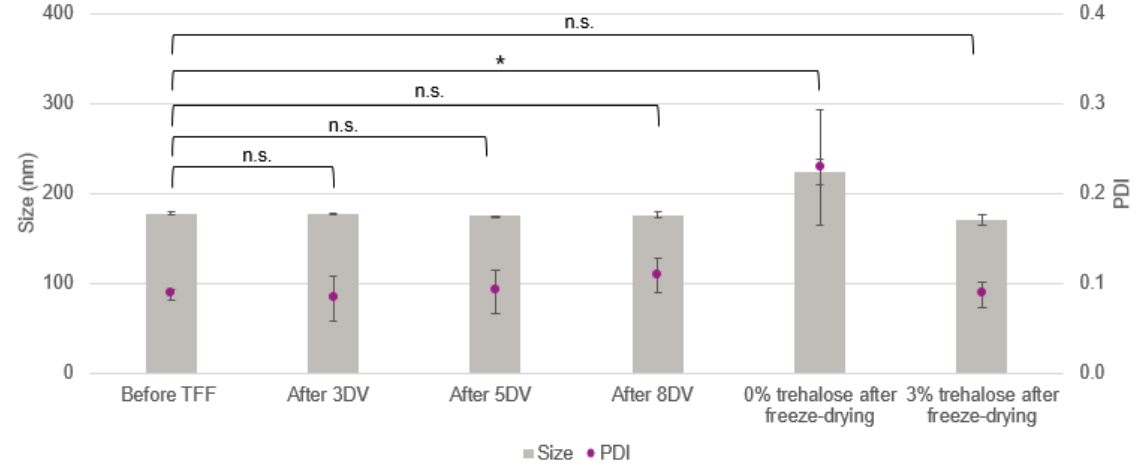
Figure 5. Size and size polydispersity of the nanoformulations before, during, and after the down-stream processes. Significant, p < 0.05 (*); nonsignificant, p > 0.05 (n.s.).